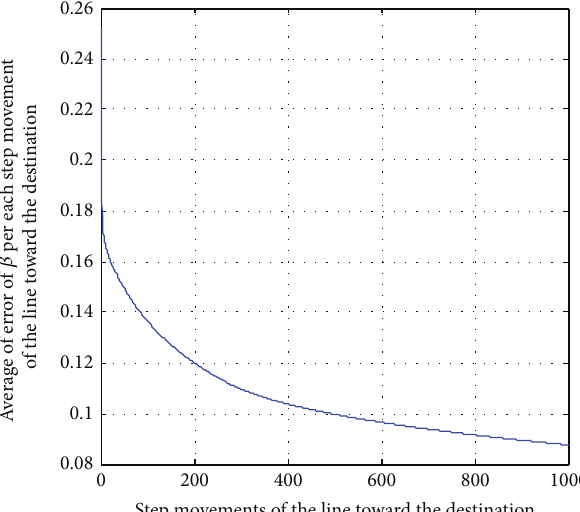
distance (shown in step movements away from the sensor up to 4000 km).